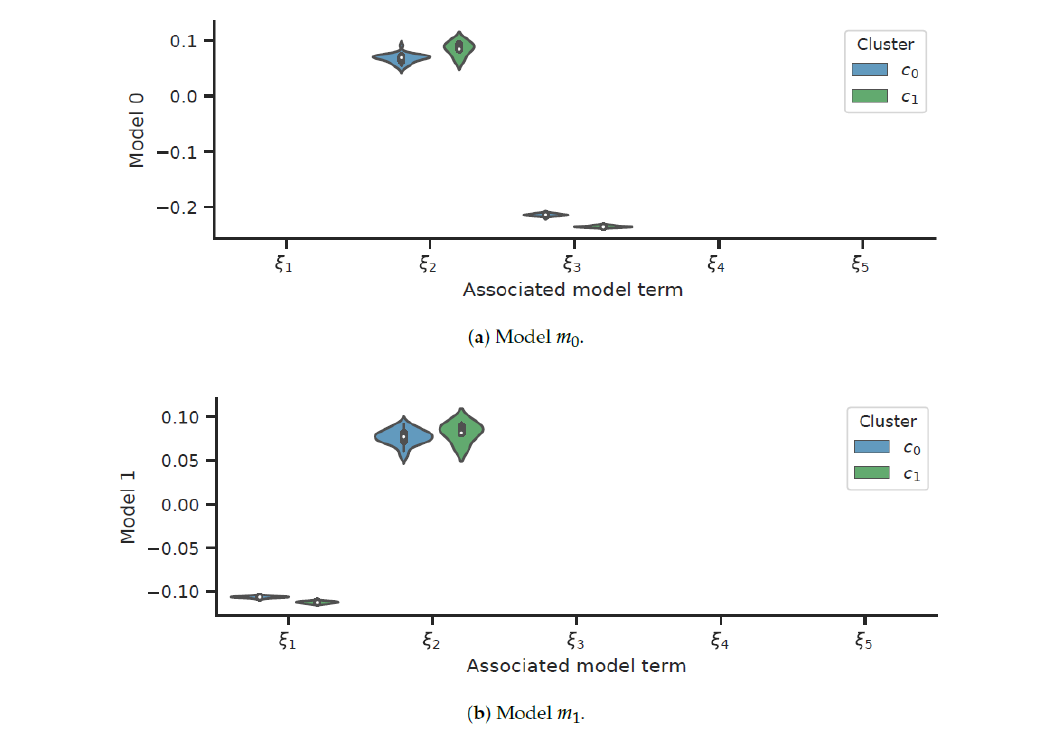
Figure 1. Coefficient magnitudes for low order SINDyc